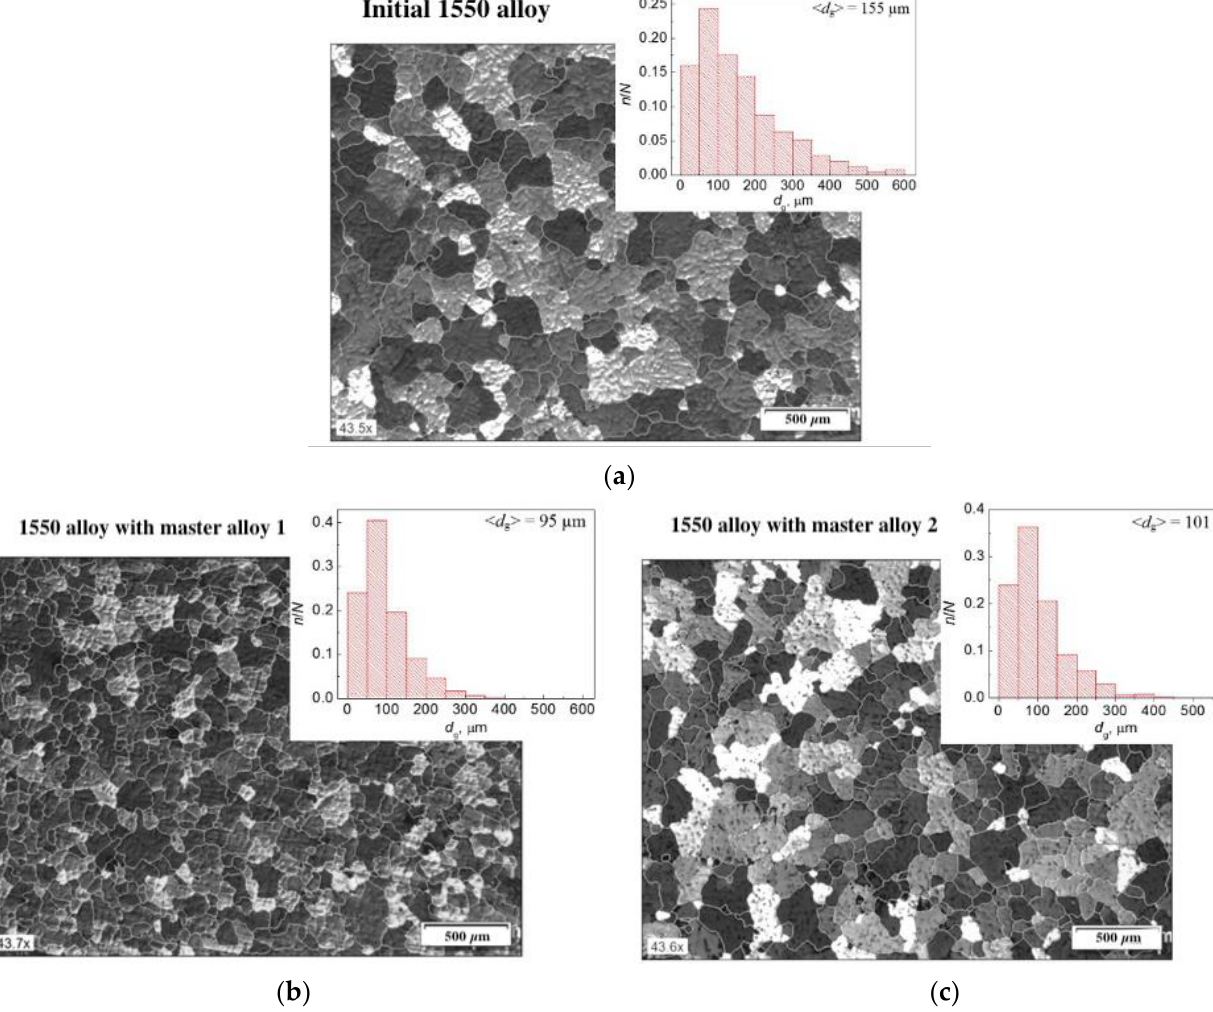
Figure 3. Optical images of microstructure and histogram of grain size distribution of the alloy: ( a ) initial 1550 alloy; ( b ) 1550 alloy with the master alloy 1 (according to Table 1); ( c ) 1550 alloy with the master alloy 2 (according to Table 1).